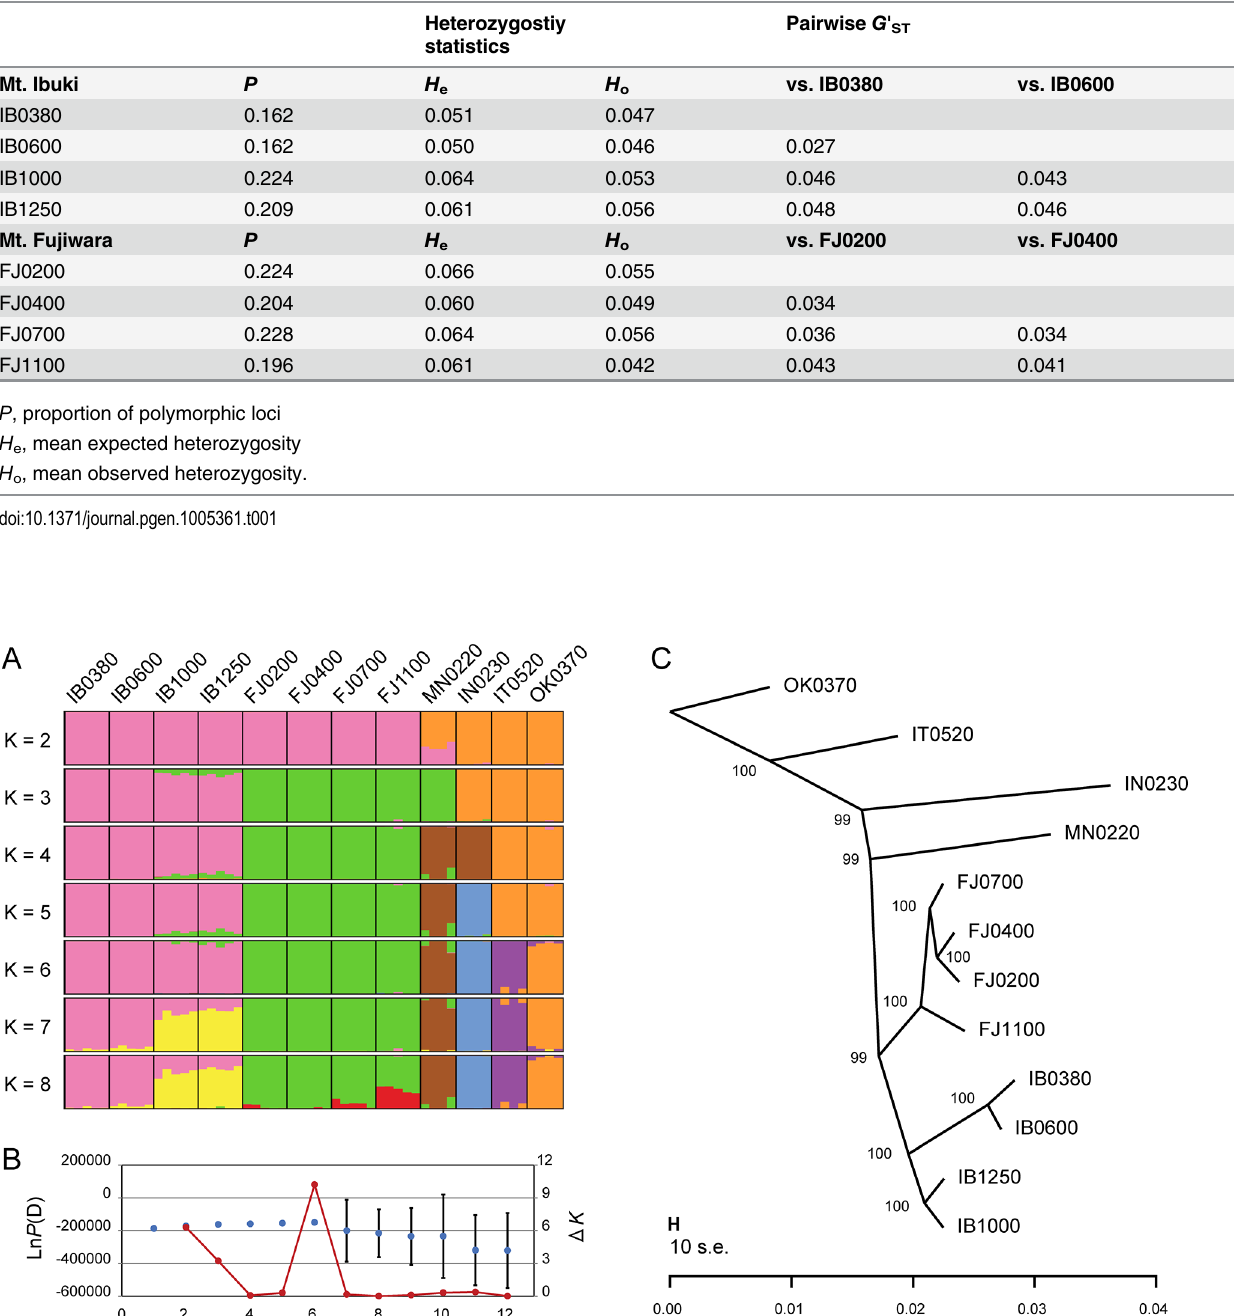
Table 1. Summary statistics of genetic diversity and differentiation among the altitude-specific populations.